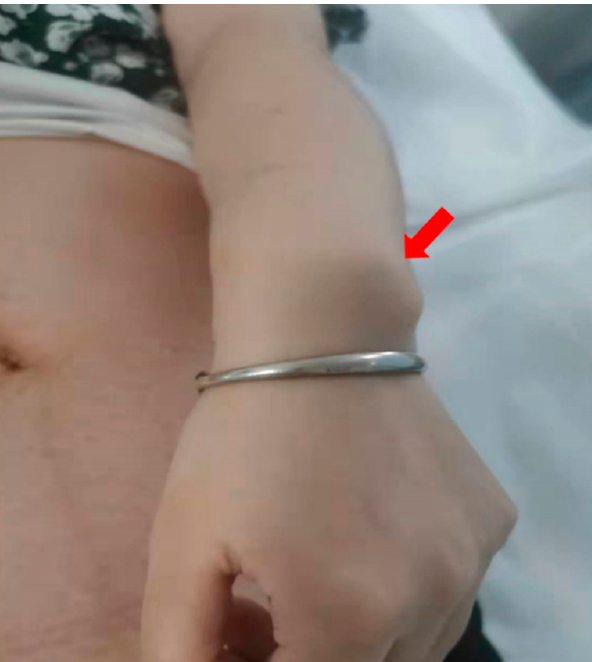
Figure 1. Madelung deformity of the wrist in the mother of case 1. Ulnar bones are protruded, forming Madelung deformity.